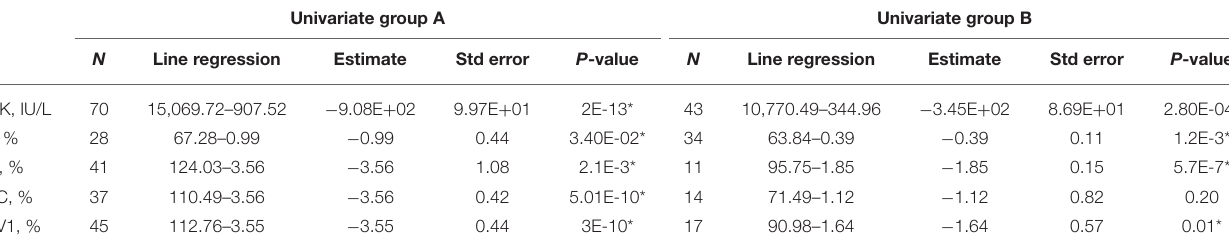
TABLE 2 | Evolution of clinical variables with aging in LGMDR4 groups A and B, as estimated by univariate generalized linear